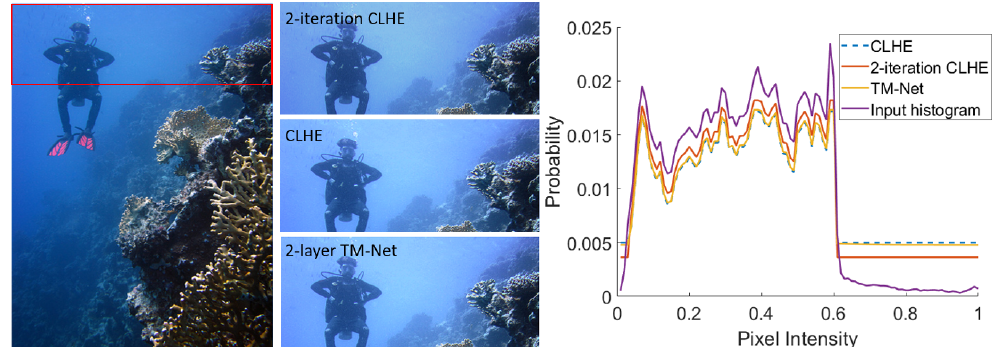
Figure 8. Left, a standard RGB image. Middle, the highlighted section enhanced with CLHE , a 2-layer TM-Net, and CLHE limited to 2 iterations. Right, input and modified histograms found by each